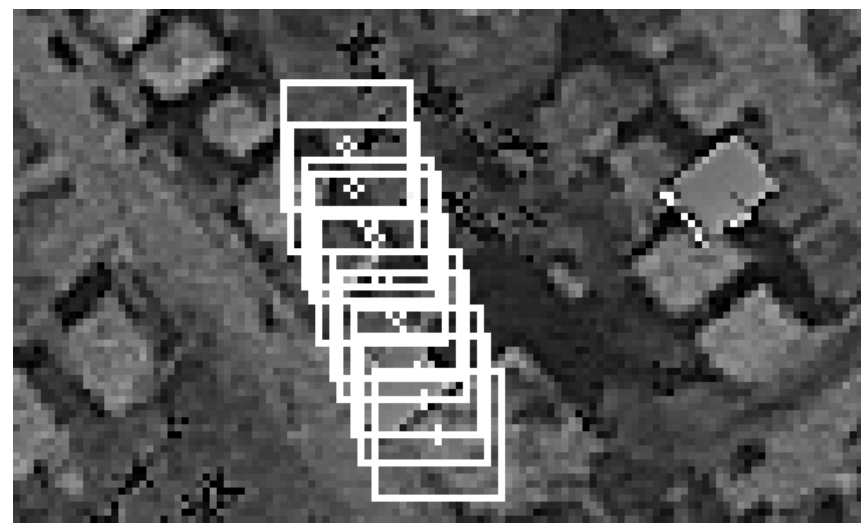
Figure 9. Simulation results. Template matching (TM) cycle merged into one image.